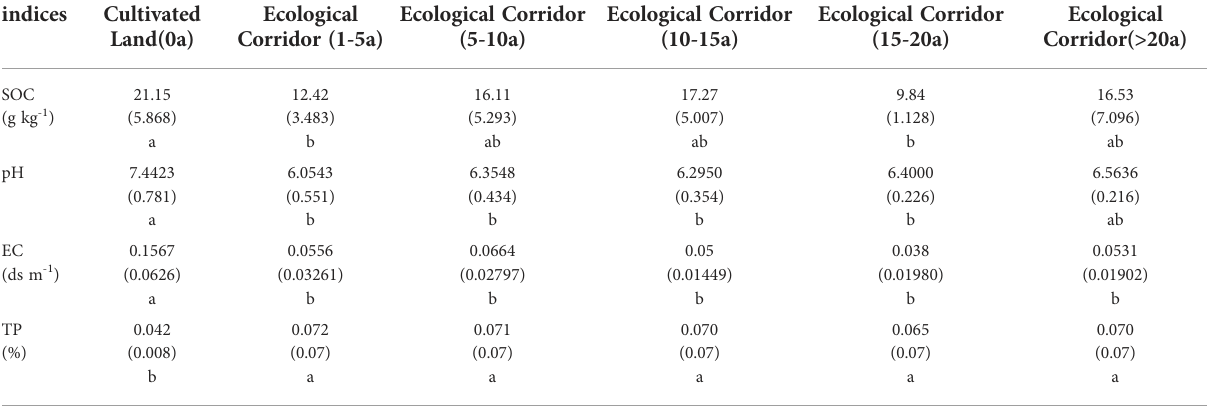
Standard deviation in brackets. Lower case letters indicate signi fi cant differences between the sites ( a =